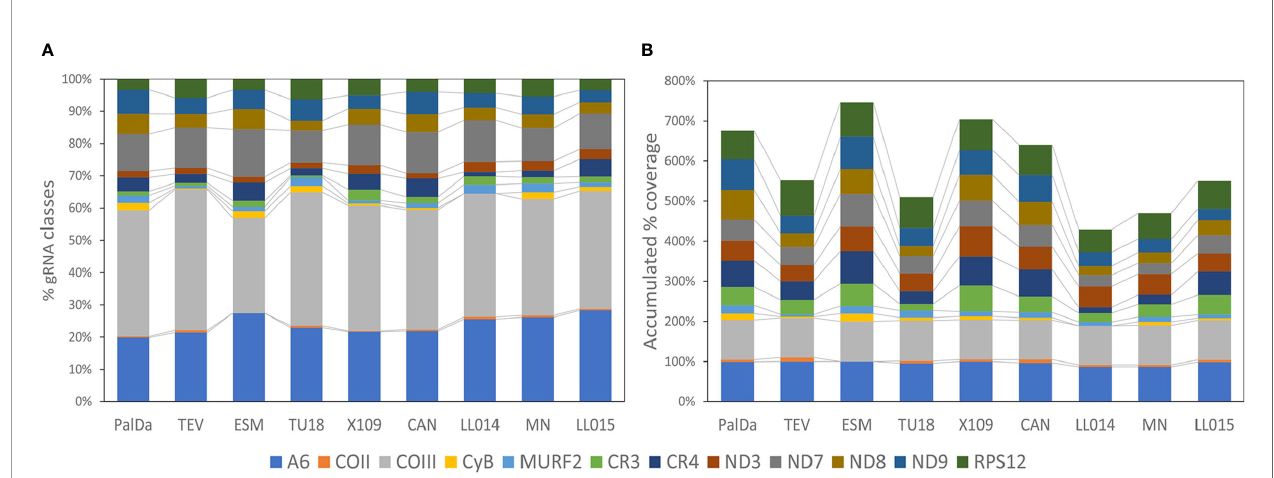
FIGURE 4 | Balanced changes in gRNA repertoires of different strains and variable coverage for different mRNAs. (A) Relative percentage of the number of gRNA classes identi fi ed for each mRNA. (B) Accumulated coverage percentage for each mRNA by gRNAs. The coverage percentage for each mRNA is calculated as the percentage of the mRNA sequence that aligned with gRNA